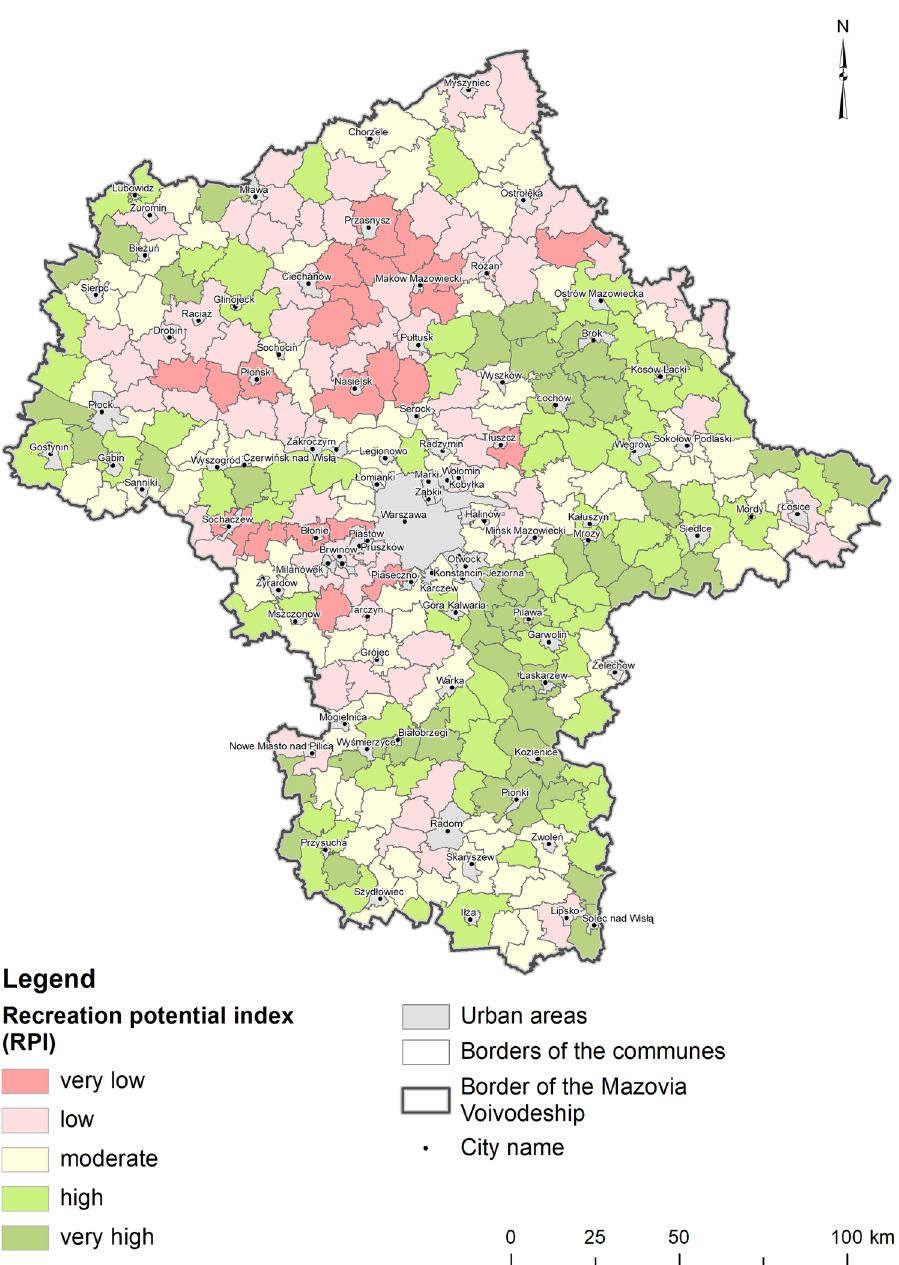
Figure 2. The tourism and recreational potential of communes in the Mazovia Voivodeship (Source: Own elaboration in ESRI ArcMap